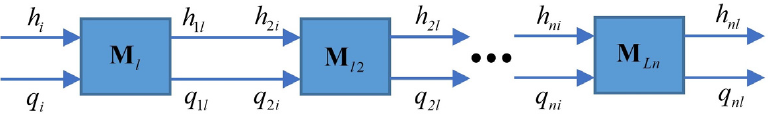
Figure 2. Four-port equivalent model when multiple tubes are connected in series.